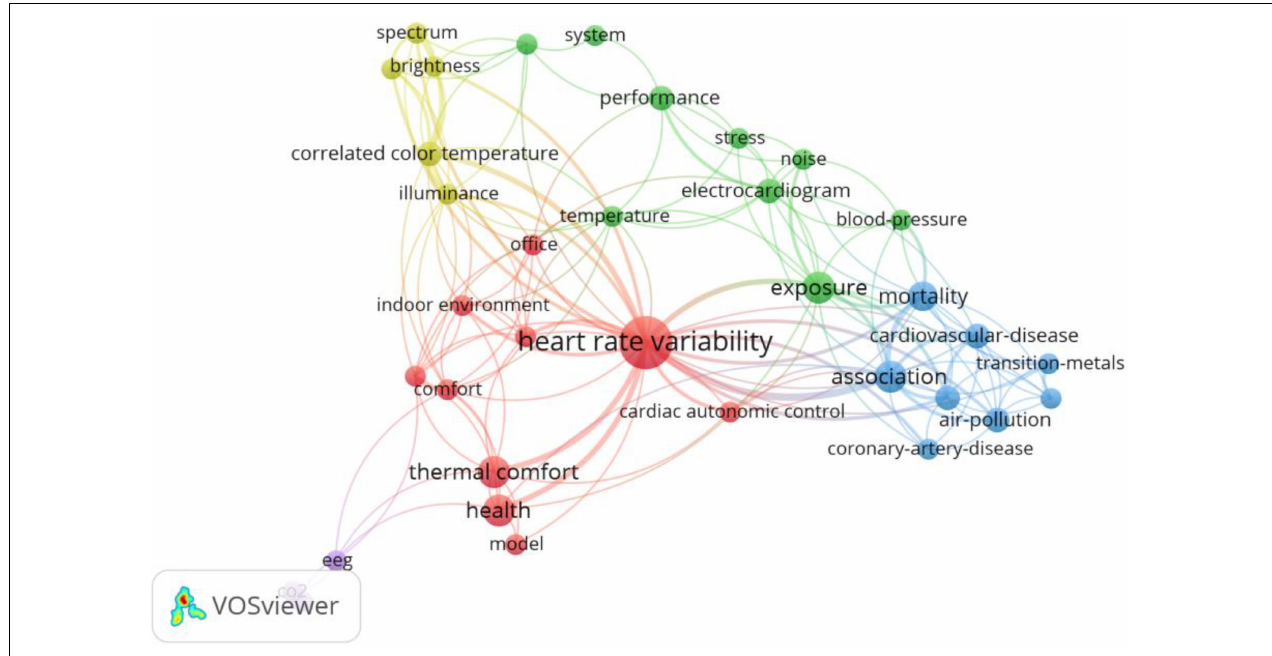
FIGURE 6 | Keywords co-occurrence network of ECG in building